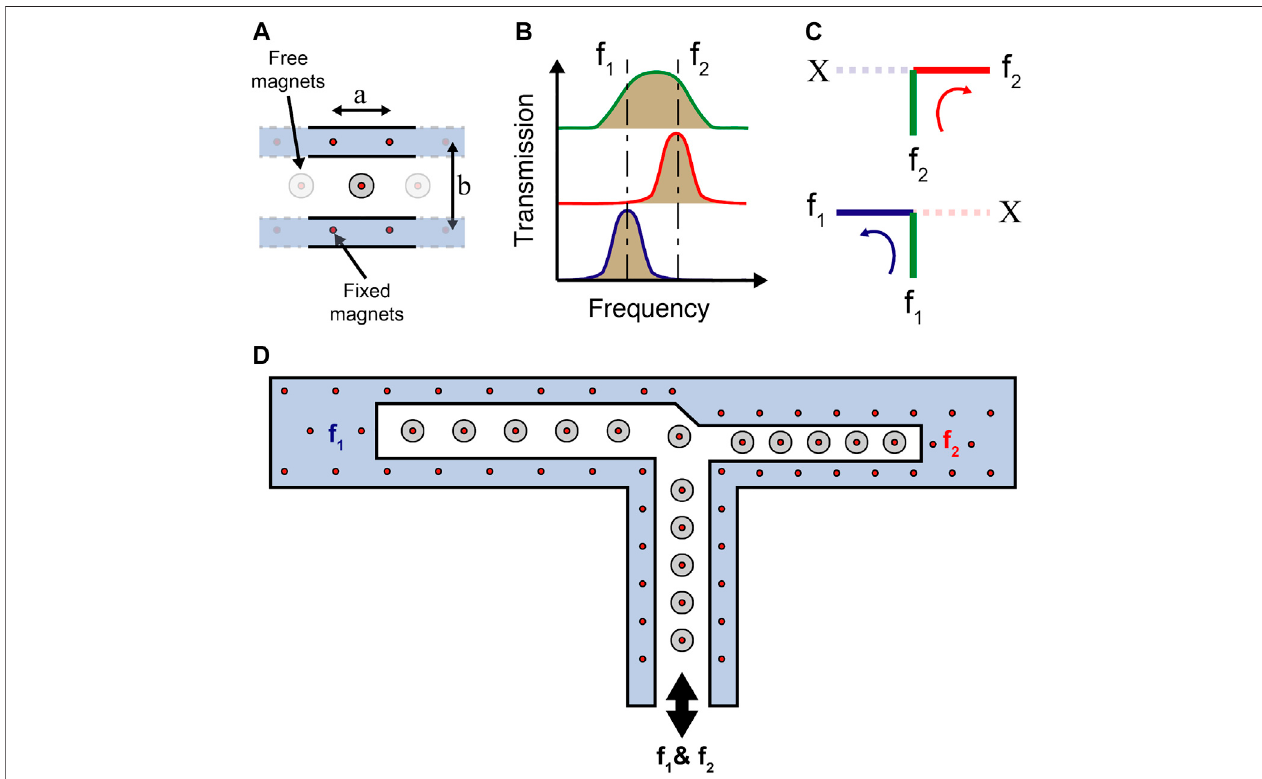
FIGURE 1 | Design concept. (A) Schematic of a unit cell depicting the locations of a and b as well as the fi xed and free magnets. (B) Transmission spectrum of channel 1 (blue), 2 (green), and 3 (red). (C) A visual representation of two different frequencies ( f 1 and f 2 ) passing through the channels. (D) A full schematic of the t-shaped demultiplexer with f 1 and f 2 excited at the vertical channel (CH. 2) and sorted into their respective